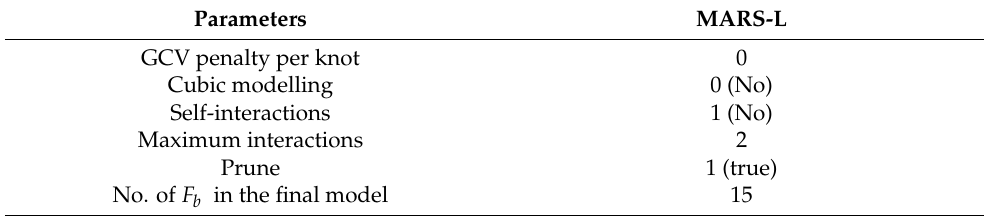
Table 2. Optimal values of effective parameters of MARS model.